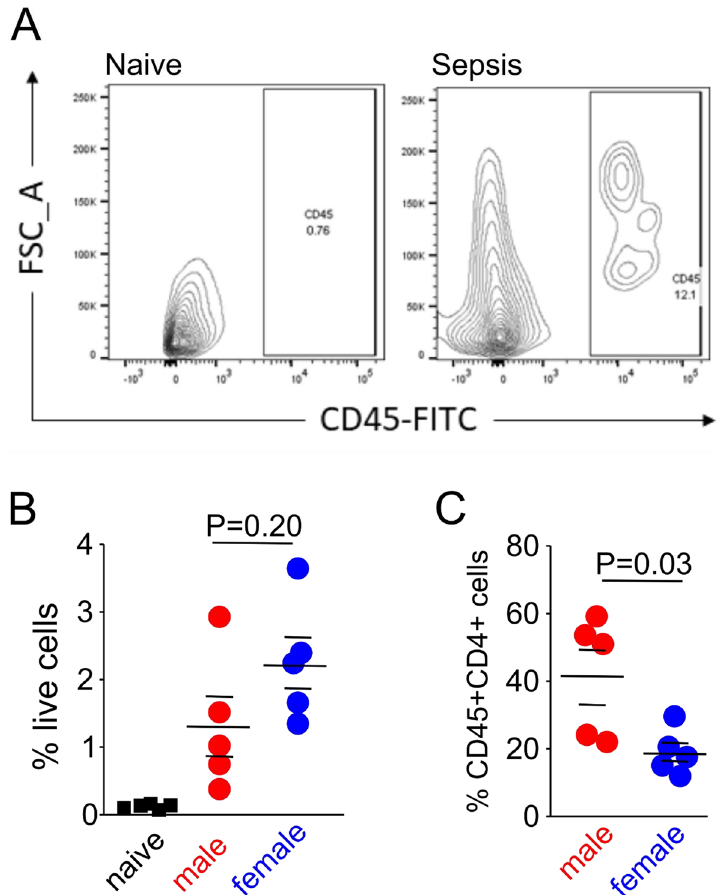
Fig. 5 Cardiac immune infiltrates after polymicrobial sepsis. A Dot plot showing CD45 + immune cells in naïve and septic heart tissue after digestion/density centrifugation. B Proportion of CD45 + immune cells in hearts obtained from wild-type mice after 18 h of polymicrobial sepsis, compared to pooled naïve mice of either gender ( n 5/sex). C Immune cell subtypes comprising CD45 + CD4 cells in hearts obtained = + from wild-type (WT) mice female and male mice after 18 h of polymicrobial sepsis. p values refer to post hoc testing after ANOVA testing for sex x condition interaction. Additional immune cell data are shown in Additional file